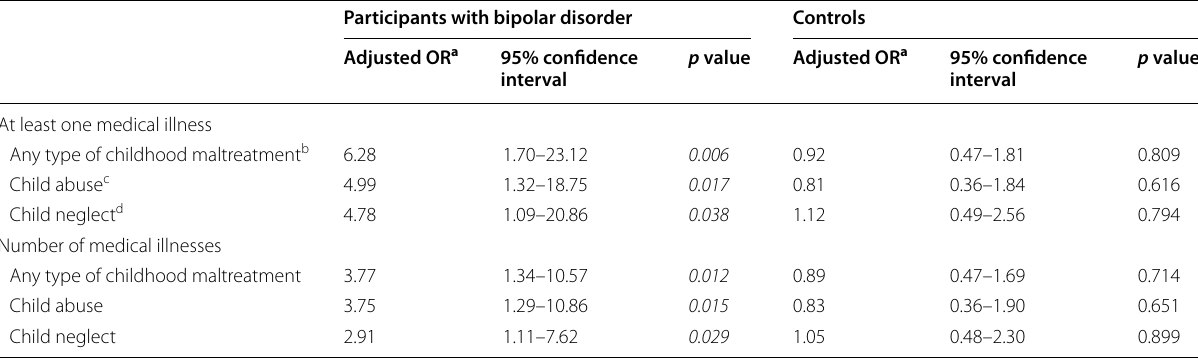
Table 3 Relationship between childhood maltreatment and medical illnesses, presented separately for participants with bipolar disorder and